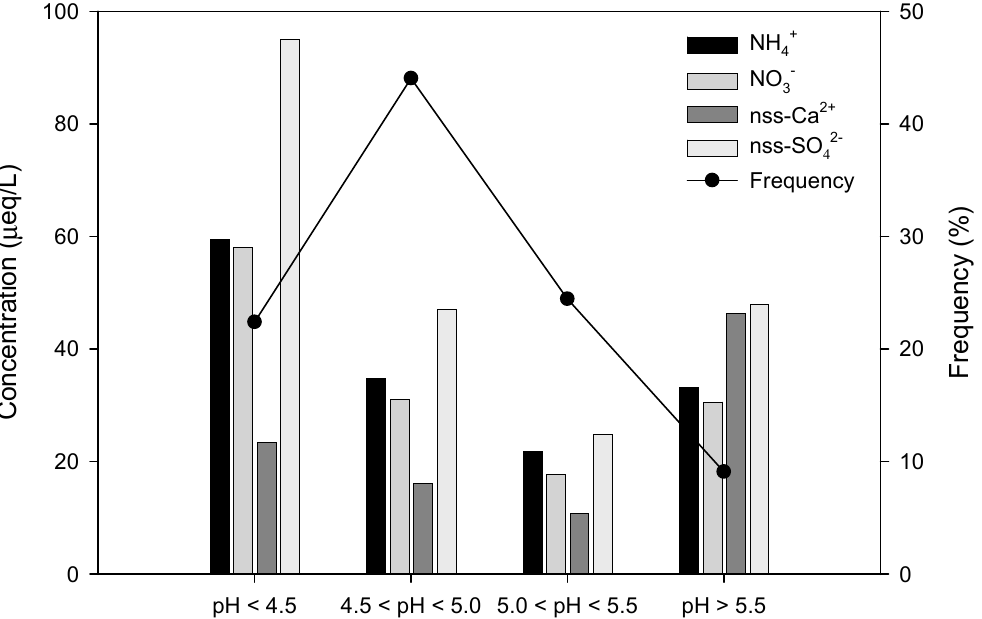
Figure 3. Variation of ionic concentration ( μ eq/L) and frequency (%) corresponding to different pH ranges of precipitation.